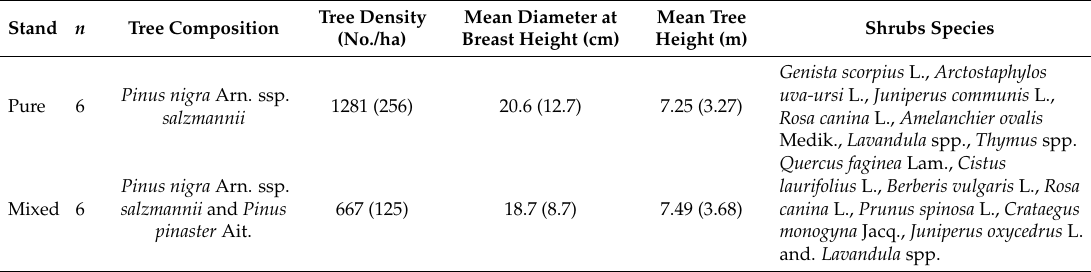
Table 1. Forest stand characteristics in the study areas. Mean vales and standard deviation. n : Number of